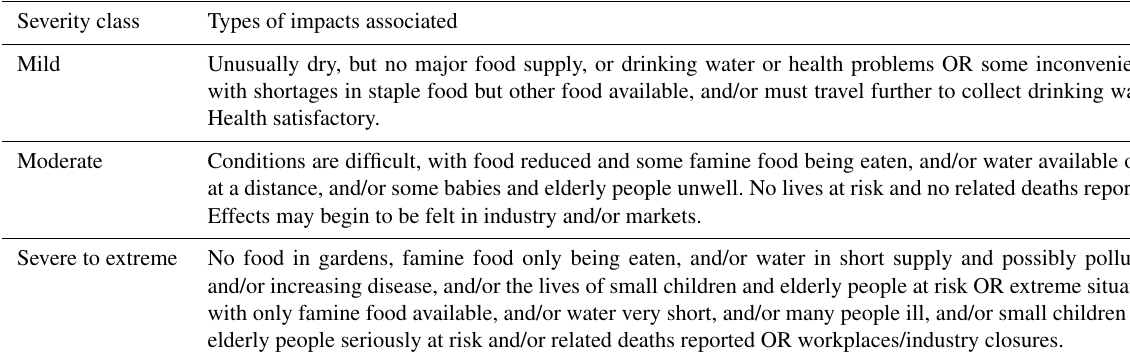
Table 6. Inclusion and exclusion criteria for the selection of literature sources to be used in the risk assessment validation. Criteria for inclusion Criteria for exclusion Literature in English Literature in other